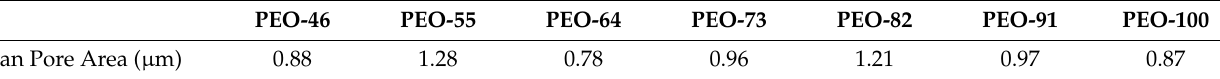
Table 5. Mean pore area estimated from image analysis.